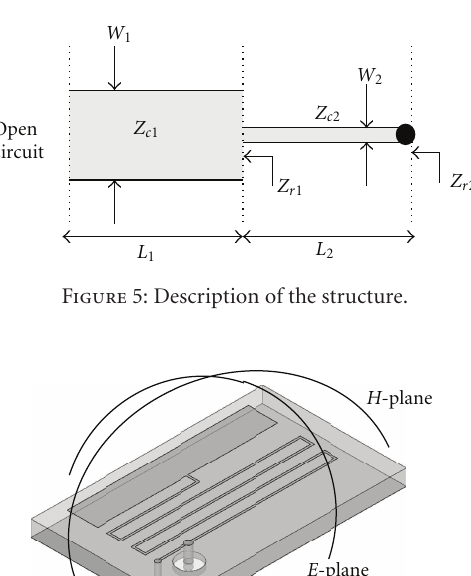
Figure 4: Short-circuited SIR antenna.